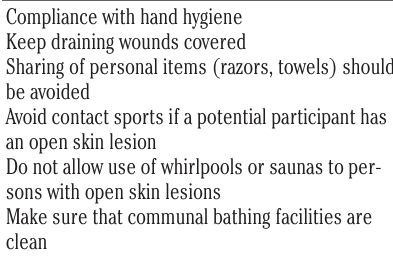
Table 2. Potential strategies for preventing transmission of S. aureus in the community. Compliance with hand hygiene Keep draining wounds covered